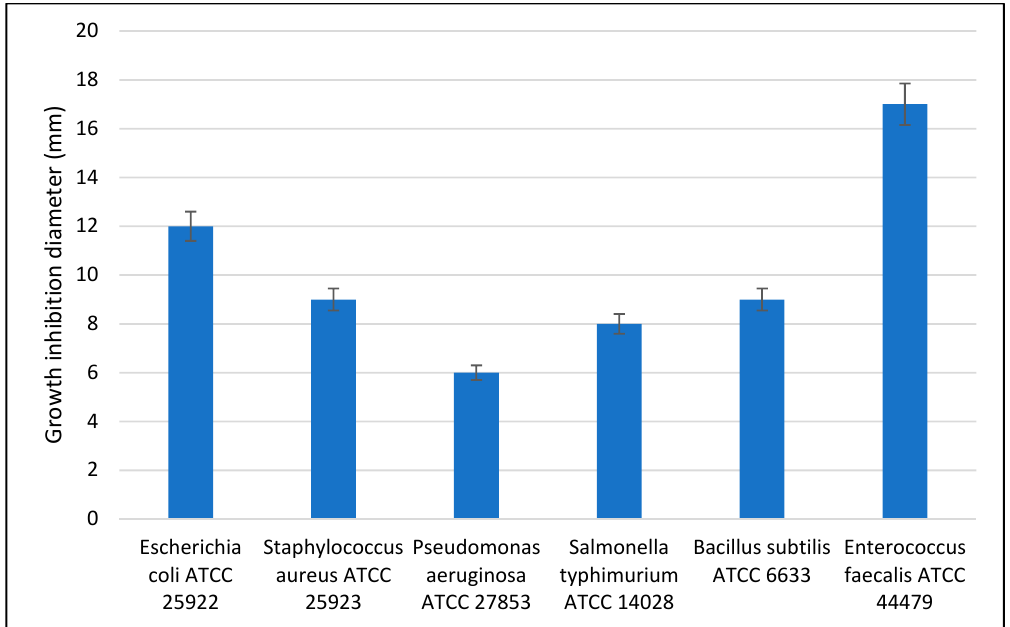
Figure 7. The antimicrobial activity of ZnO nanoparticles.